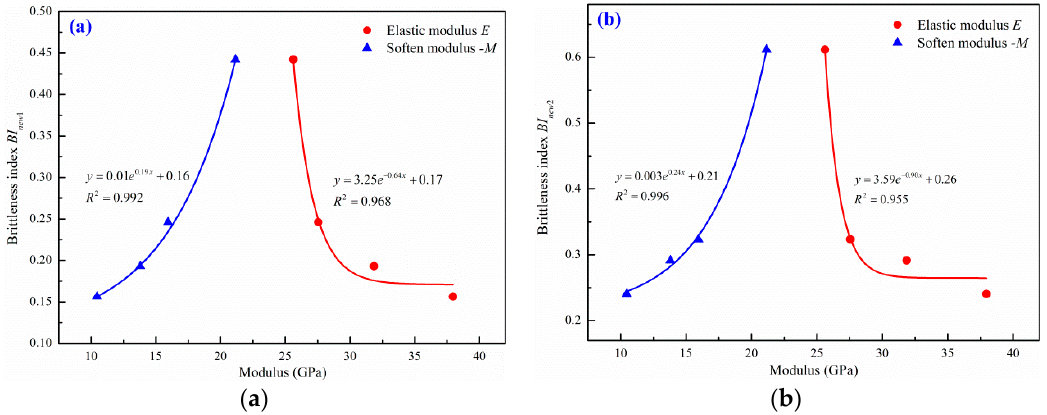
BI and ( b ) BI . Figure 14. Relationship between modulus and brittleness indexes ( a ) BI new 1 and ( b ) BI new 2 . 1 new 2 new